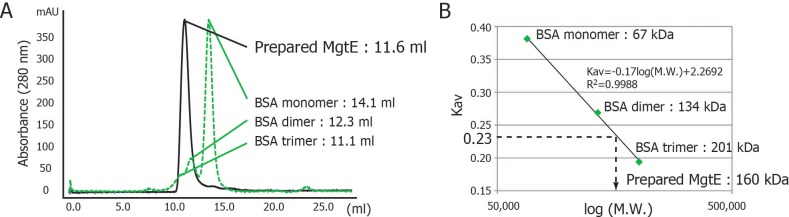
Analysis of the oligomeric state of purified full-length MgtE in DDM micelles.(A) The elution profile of purified MgtE by size exclusion chromatography (SEC) on a Superdex 200 GL 10/300 column (black solid line), along with a standard sample of bovine serum albumin (BSA) (green dashed line). The running buffer was 20 mM HEPES-NaOH (pH 6.1), 100 mM NaCl, and 1 mM DDM. The elution volumes were 11.6 mL for purified MgtE, 14.1 mL, 12.3 mL, and 11.1 mL for the BSA monomer, dimer, and tetramer, respectively. (B) Estimated distribution coefficients (Kav) from the elution volume in (A) were plotted against logarithmic molecular weight (M.W.). The solid line is the best fit function as indicated in the graph of plots of the BSA monomer, dimer, and tetramer. The estimated apparent M.W. of purified MgtE (Kav = 0.23) is approximately 160 kDa, suggesting that the purified MgtE, whose theoretical M.W. is 50 kDa, exists as a dimer in DDM micelles, as the apparent M.W. of DDM micelles is 60 kDa.